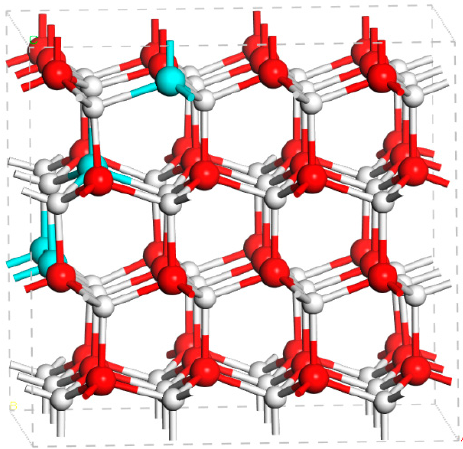
Figure 5. Atomic structure for the supercell of In 4 Ga 44 N 48 . In, Ga and N atoms denoted by cyan, red and white balls, respectively.